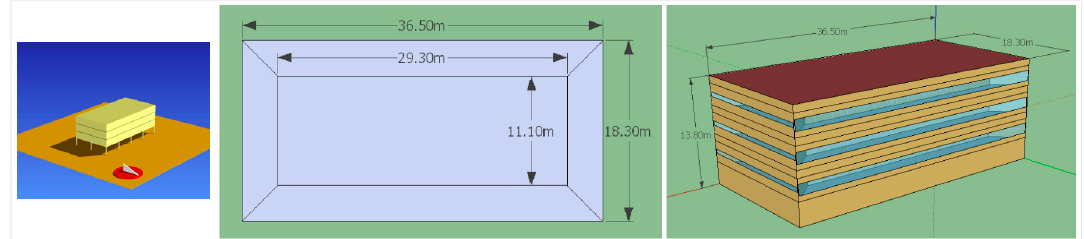
Figure 4. Building Type B model geometry and zone division [55].